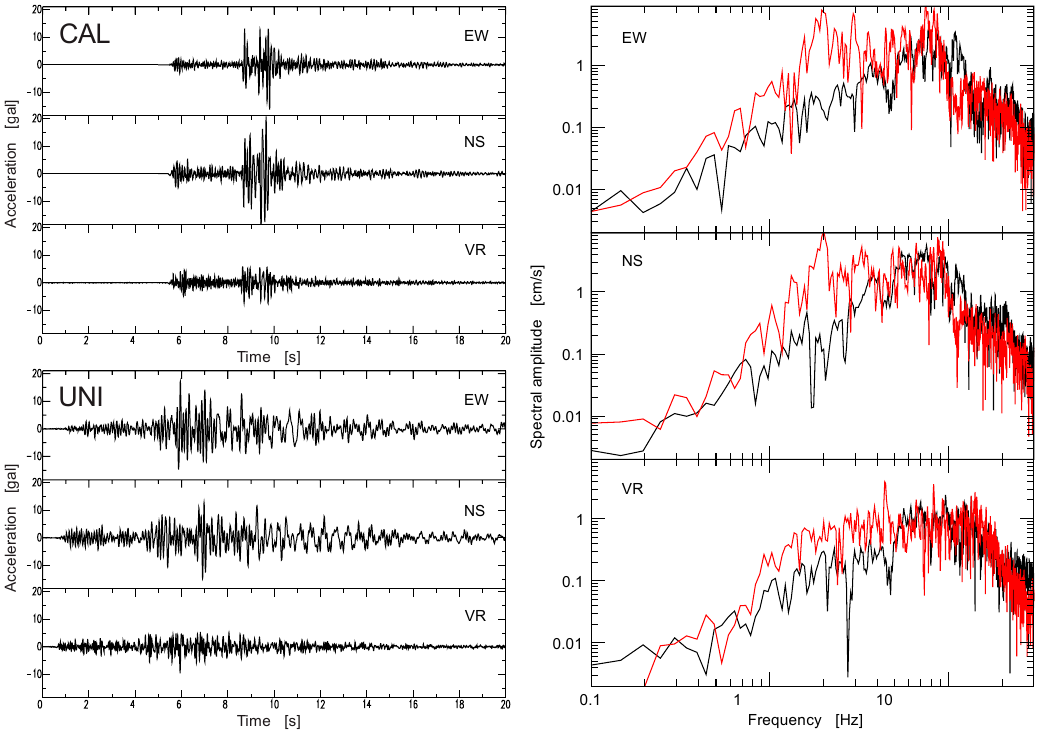
Figure 4. Example of the acceleration records of the aftershocks (frames on the left ) and their Fourier amplitude spectra (frames on the right ). The traces shown correspond to event 7 (Table 1), recorded by stations, CAL and UNI. Spectra plotted with black lines correspond to station CAL, while those plotted using red lines correspond to station UNI.